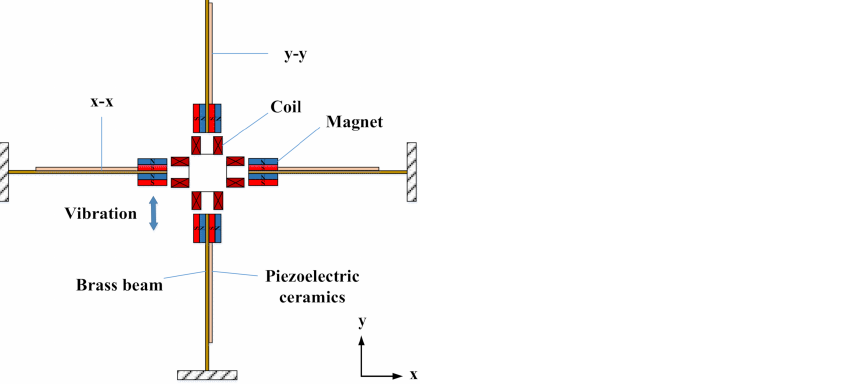
Figure 3. Schematic diagram of the piezoelectric–electromagnetic coupling cantilever